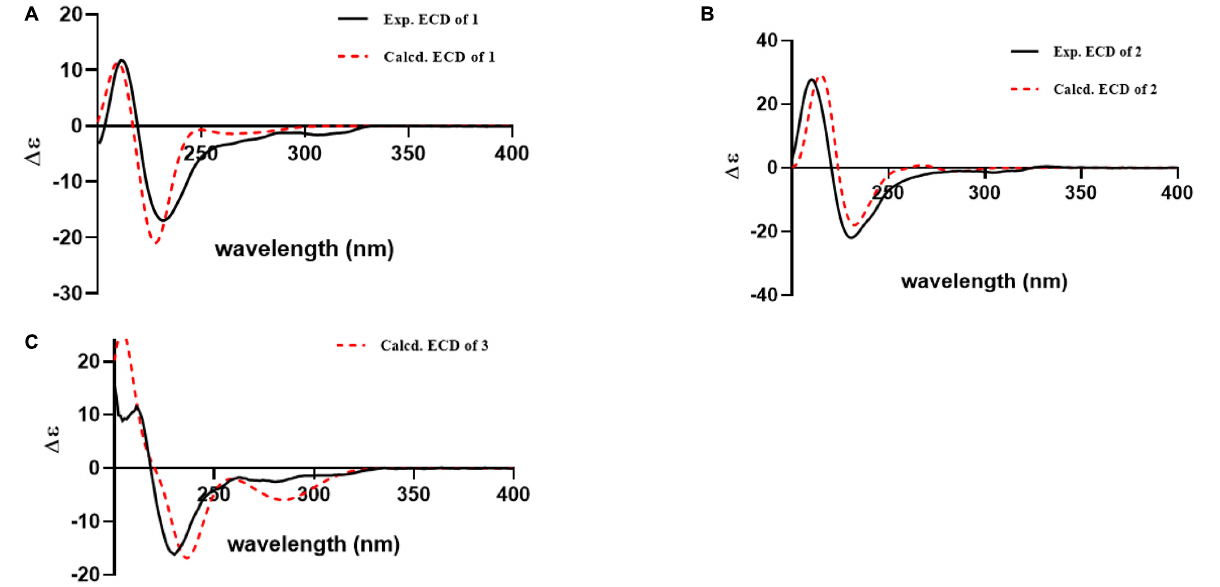
Frontiers in Microbiology |